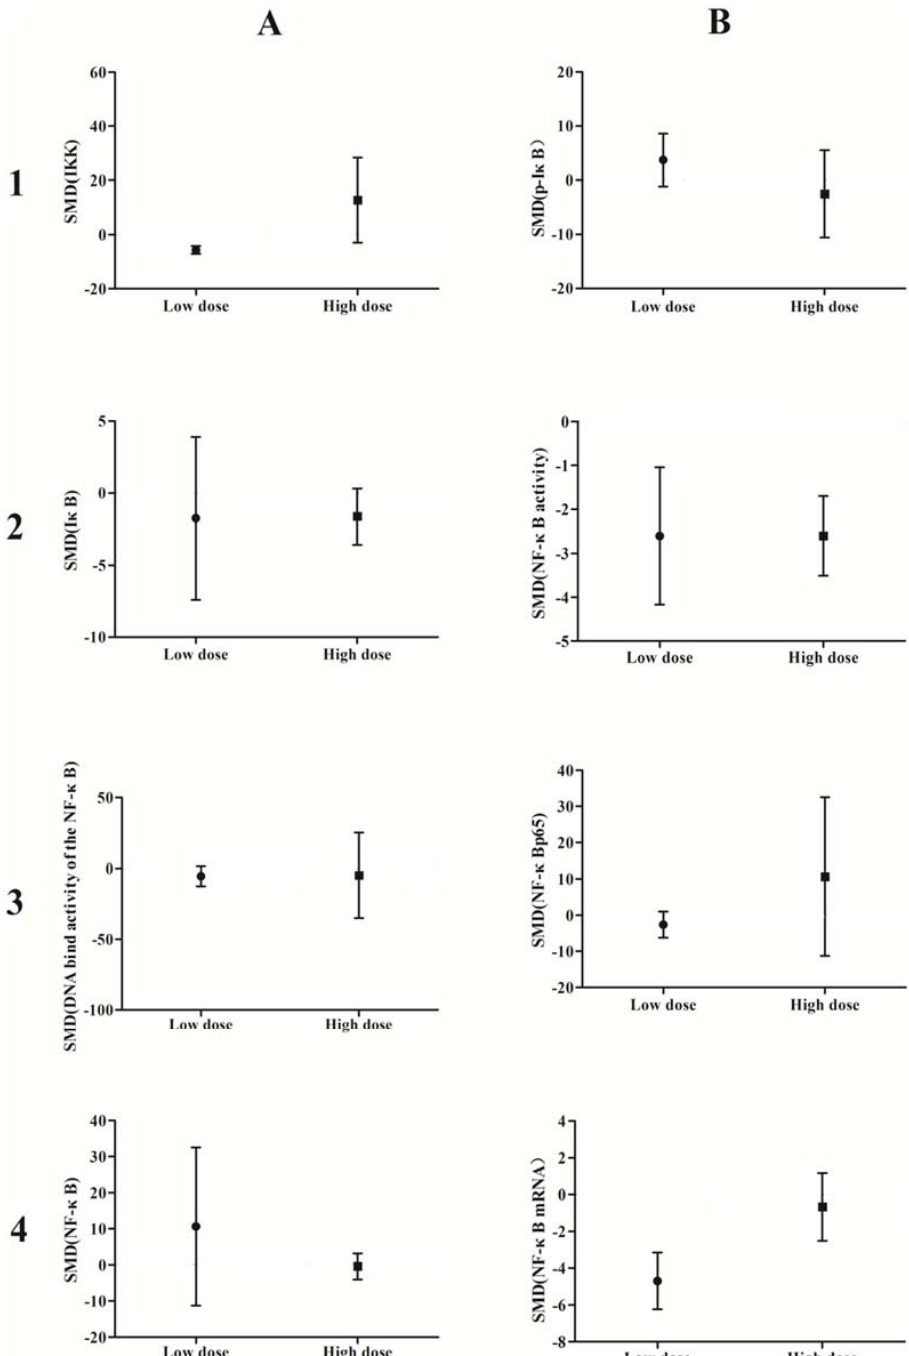
Figure 11. Subgroup analyses to determine the effects of arsenic on NF ‐κ B. Based on exposure dose analysis, low doses of arsenic exposure were found to reduce IKK(A1), NF ‐κ B activity (B2), and NF ‐κ Bp65 expression. Abbreviations: SMD = standardized mean difference. 1 , 2 , 3 , and 4 represent the row number, A and B refer to the column number.